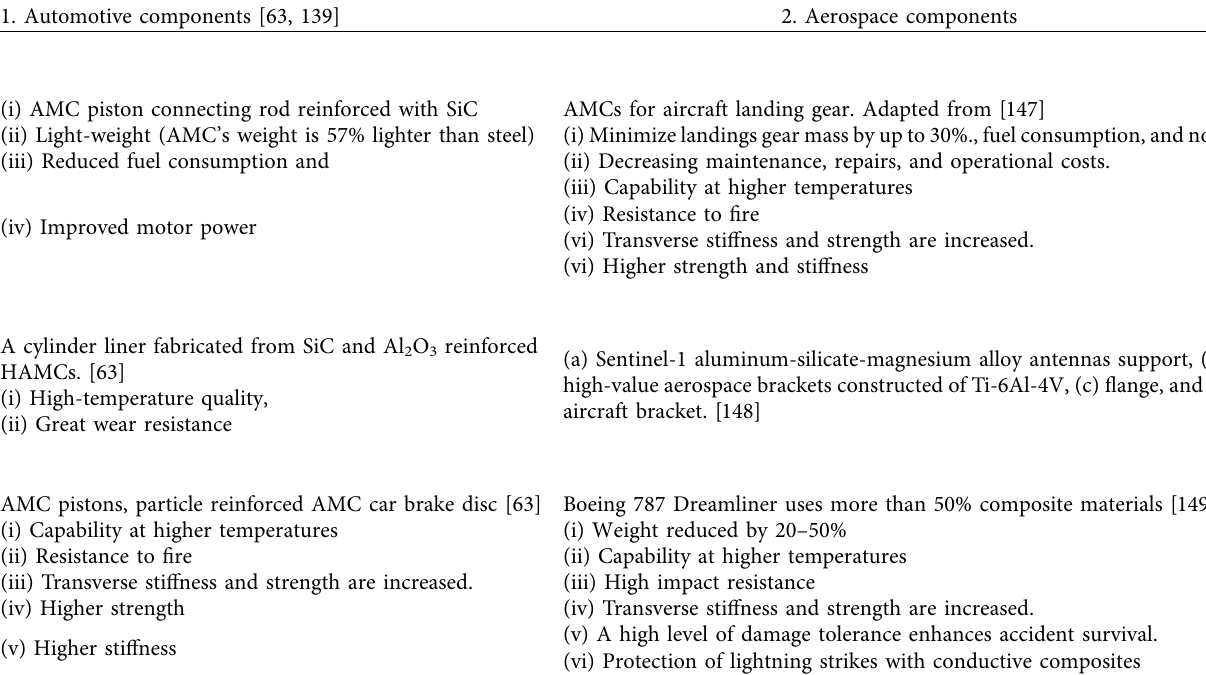
Table 14: Examples of the current application areas and advantages of AMCs and